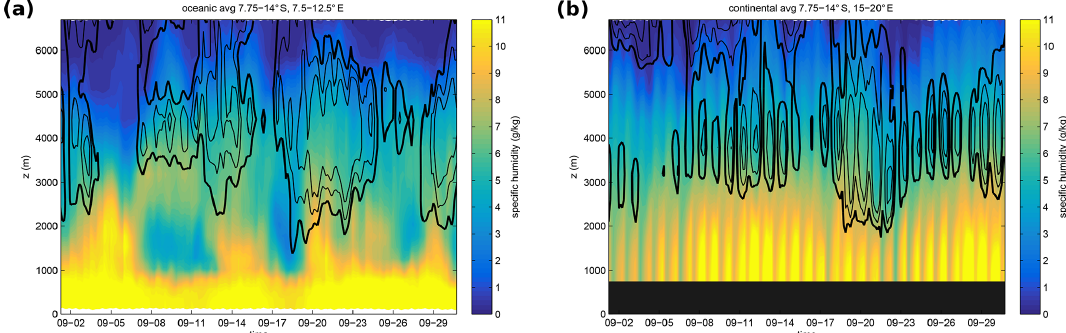
Figure 10. Oceanic (a) and continental (b) specific humidity (shaded) overlaid with zonal wind speed (black contours) from the ERA5 reanalysis. The thick black lines indicate the threshold of the AEJ-S (6m/s) with thin black lines showing 8 and 10m/s easterly velocities.